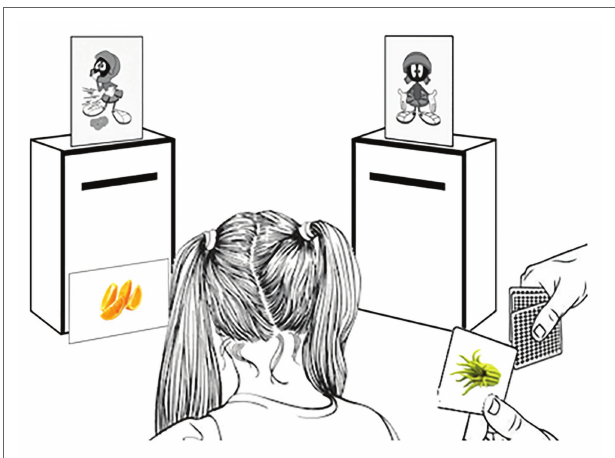
FIGURE 3 | Apparatus of the property generalization